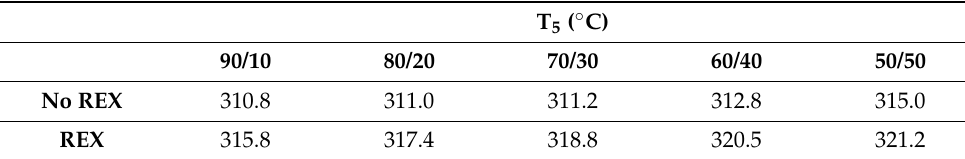
Table 2. Onset temperatures of the thermally activated degradation of PLA/PA bioblends, with and without reactive extrusion of PLA.